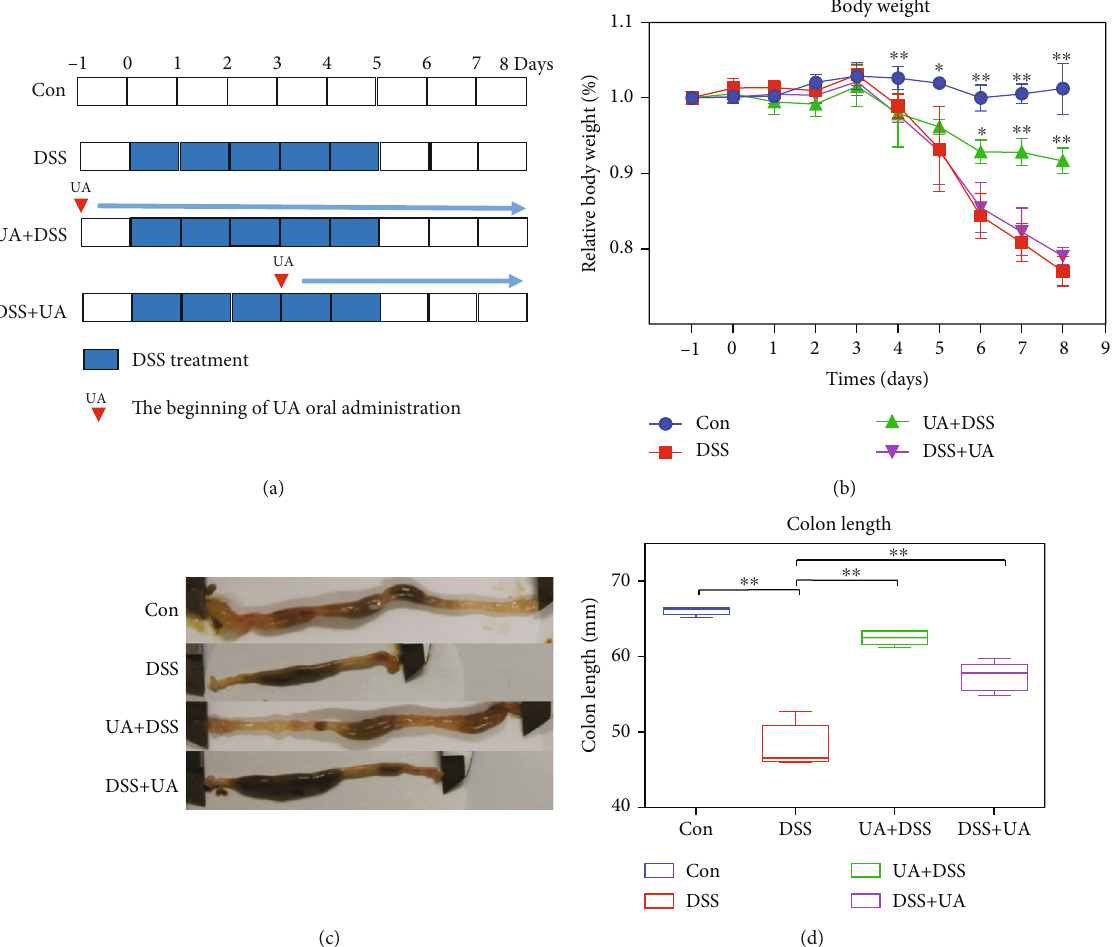
Figure 1: E ff ects of the UA on DSS-induced UC model. (a) Flow chart and time point of the DSS-induced UC model and UA treatment. The blue frame represented a 3% DSS drinking solution for one day. (b) The daily record of body weight in the DSS-induced UC model and UA treatment groups ( n = 8 ). (c) The morphology and length of the colon in the DSS-induced UC model and UA treatment groups. (d) The box plot of colon length in the DSS-induced UC model and UA treatment groups ( n = 8 ). Data represent the mean ± SD of values per group. Statistically signi fi cant results in di ff erent groups are marked by ∗ P < 0 : 05 and ∗∗ P < 0 : 01 . There was no signi fi cant di ff erence in the unmarked